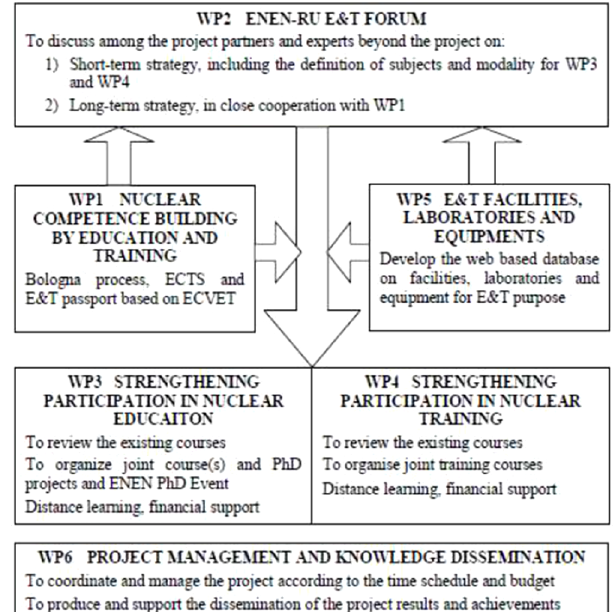
Fig. 6. Functional sketch of the ENEN-RU II Project.